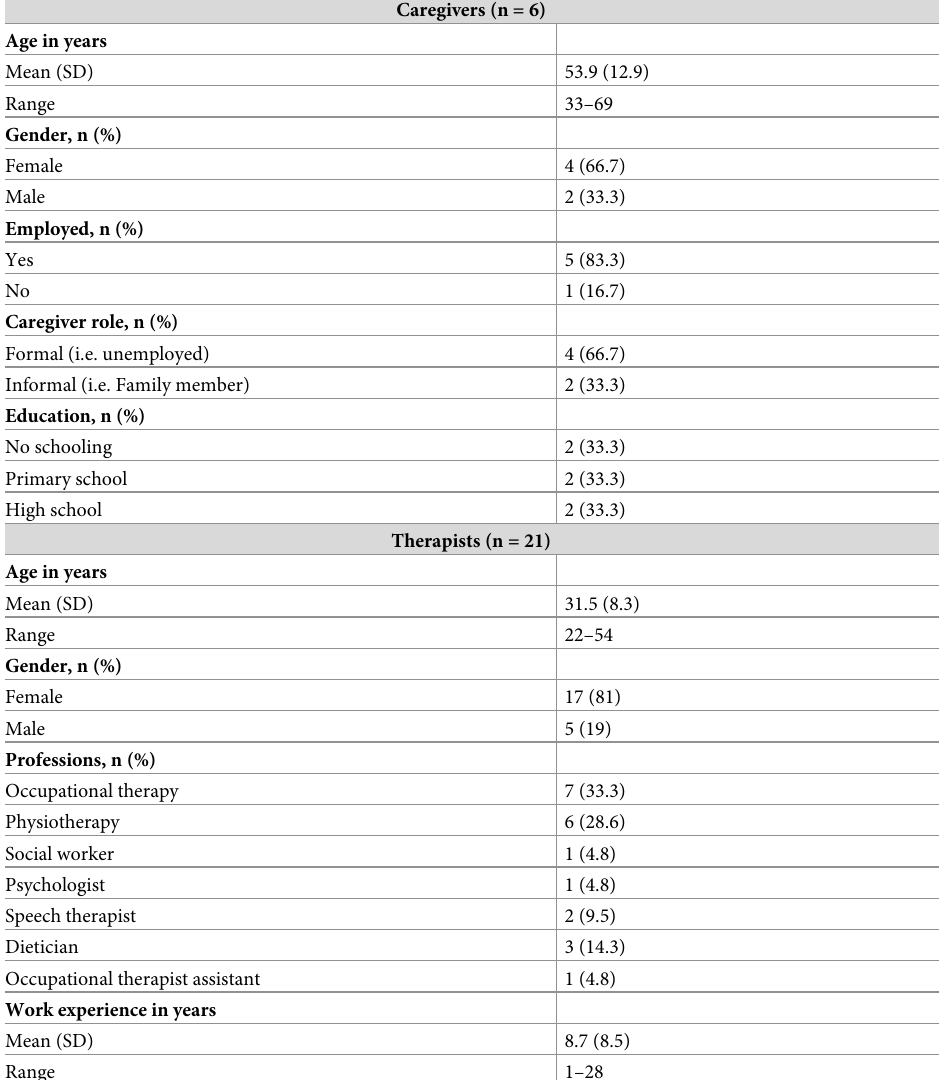
Table 2. Demographic data for the caregivers and the